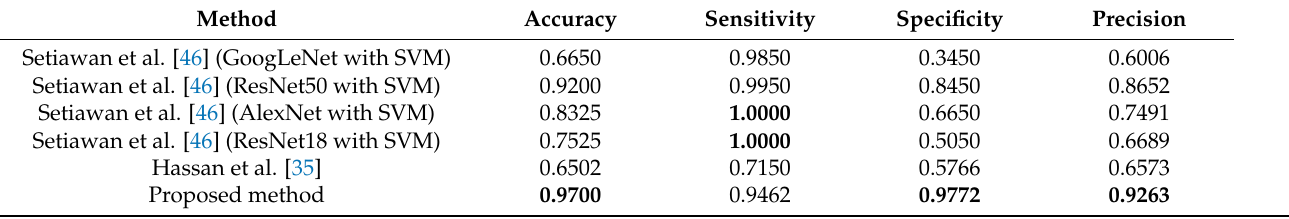
Table 2. Performance comparison of the proposed method with other neovascularization detection methods. The best values are indicated in